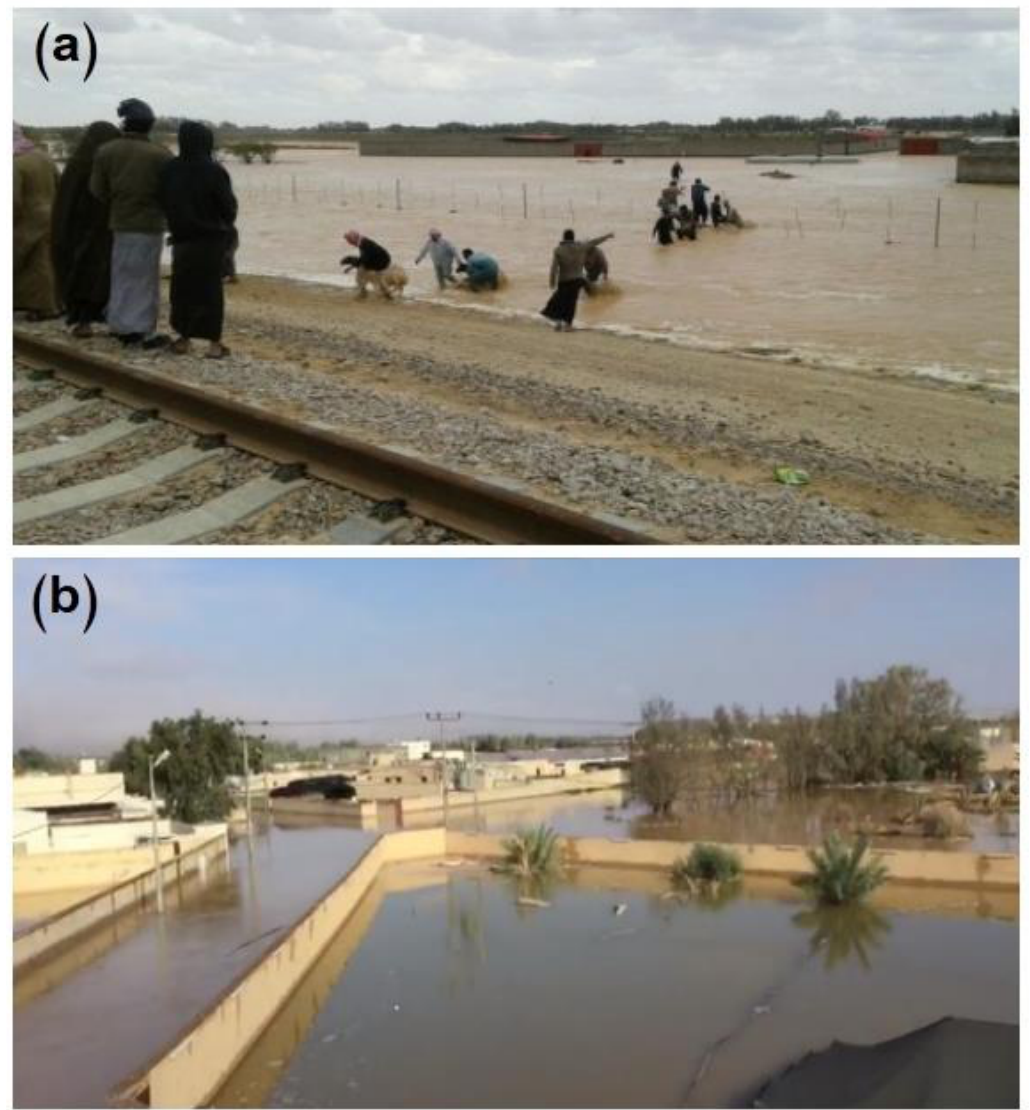
Figure 14. ( a ) Displacement of the inhabitants of the Bayer wadi as a result of flooding without the presence of floodwater drainage facilities; and ( b ) flooding of urban communities near the Al-Shamal train pathway.